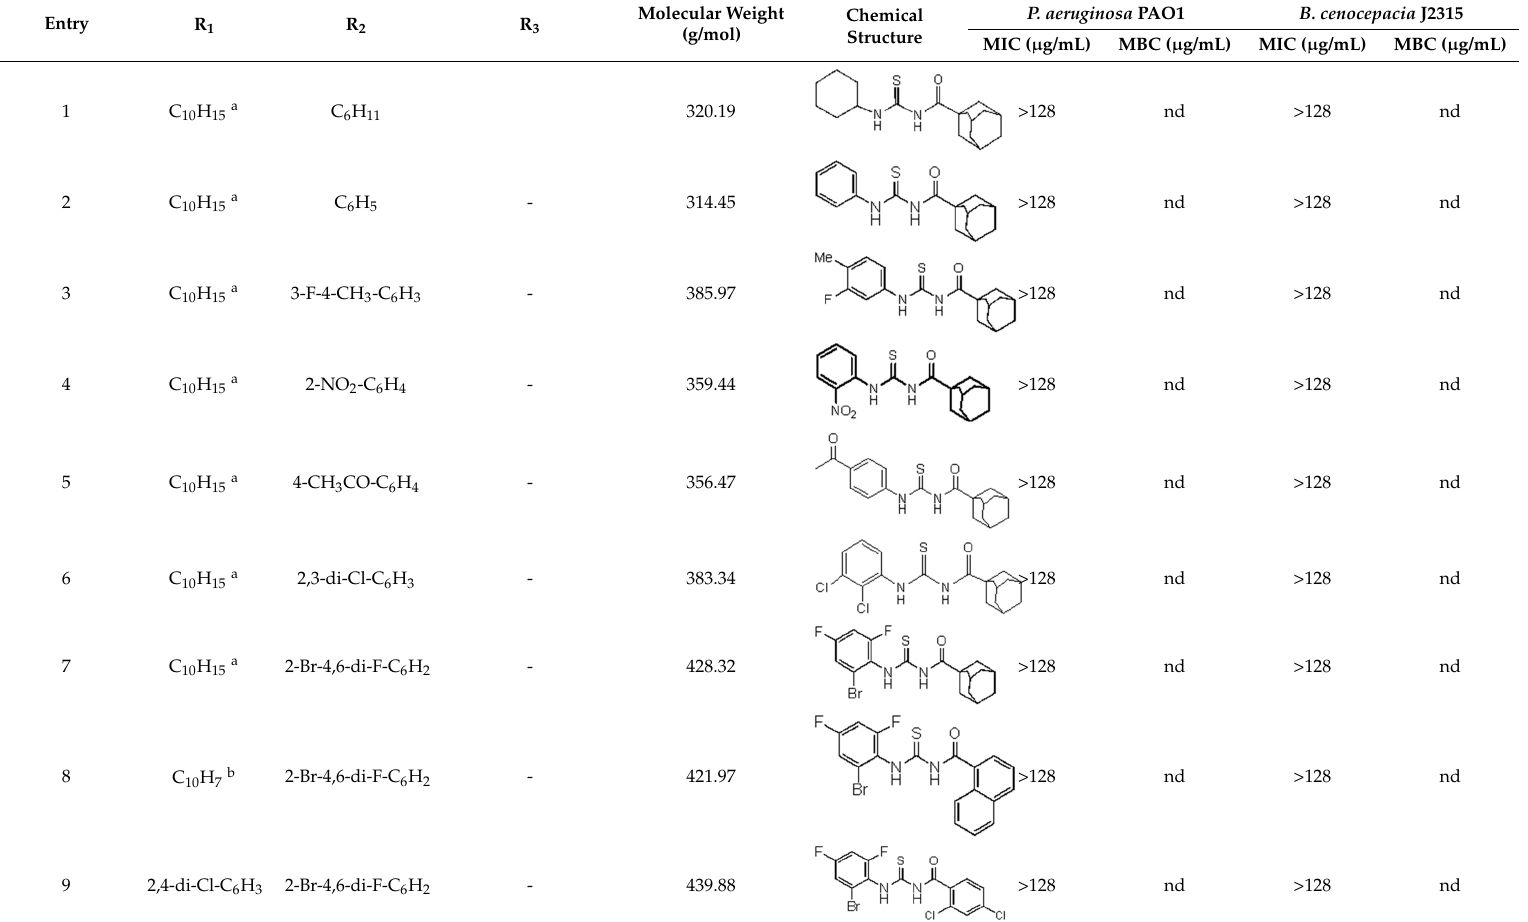
Table 1. Activities of newly obtained compounds and common antibiotics used in clinical treatments against Pseudomonas aeruginosa PAO1 and Burkholderia cenocepacia J2315.